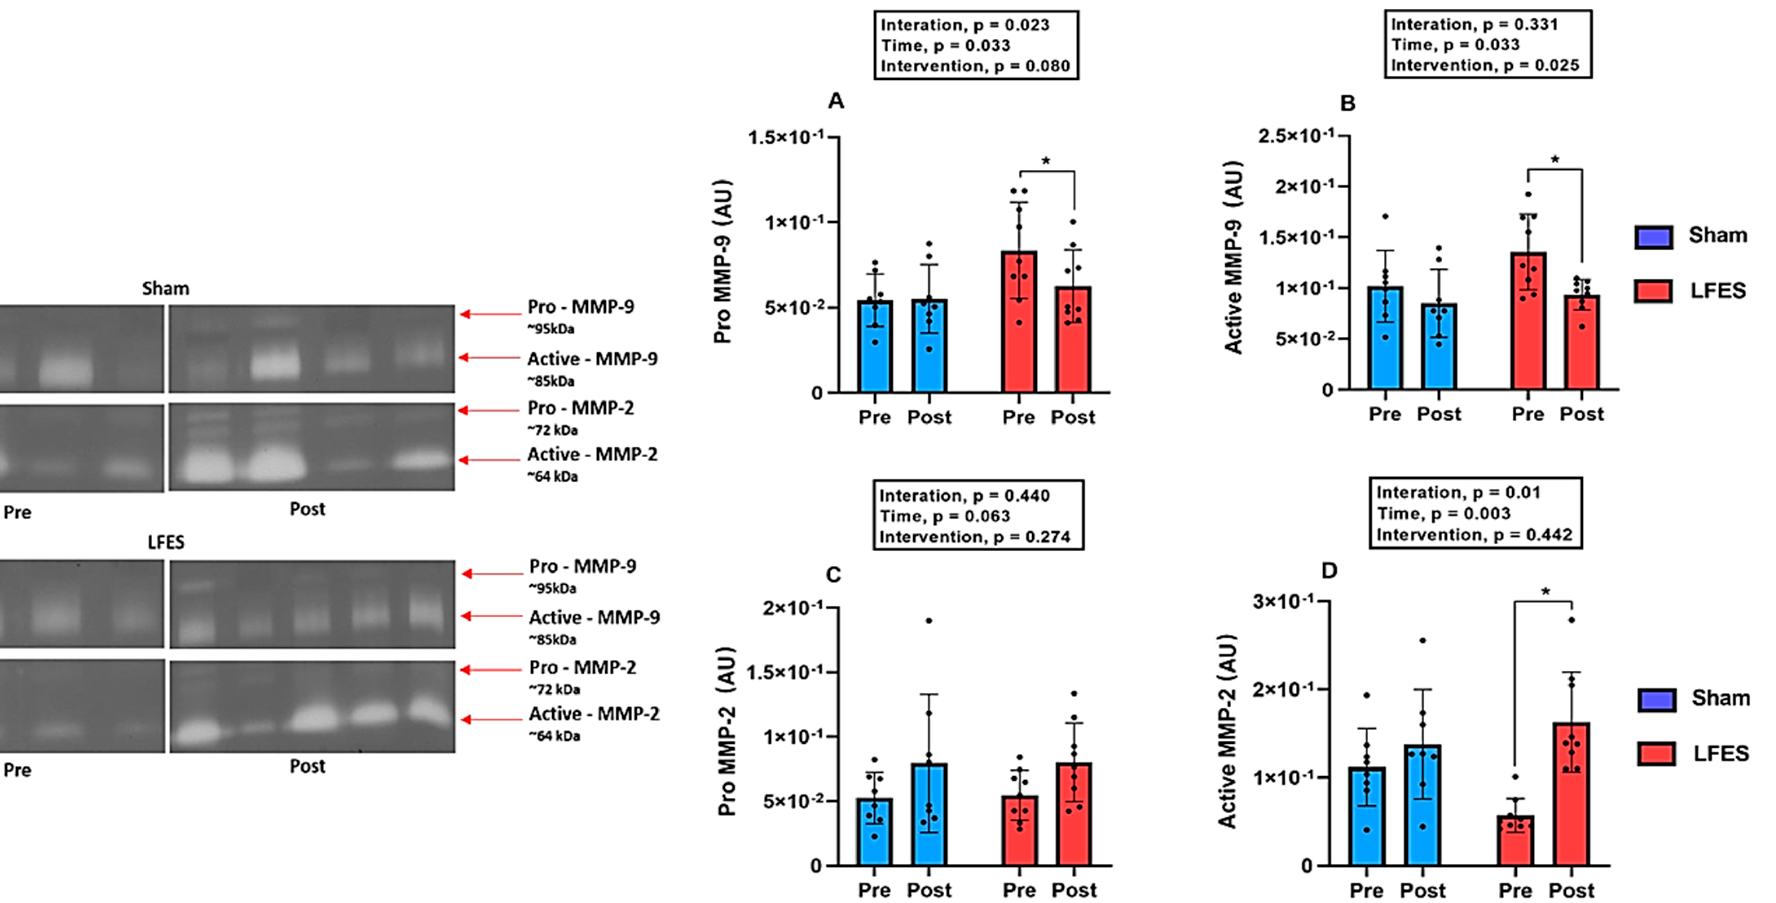
Figure 2. Low-frequency electrical stimulation (LFES) affects matrix metalloproteinase activity in heart failure with reduced ejection fraction (HFrEF). Note : Data presented as mean (SD). Optical densitometry of zymographic bands of MMP-2 in arbitrary units (AU). ( A ) Pro MMP-9 activity; ( B ) Active MMP-9 activity; ( C ) Pro MMP-2 activity; ( D ) Active MMP-2 activity; Pre = baseline; Post = after 10 weeks; * p <